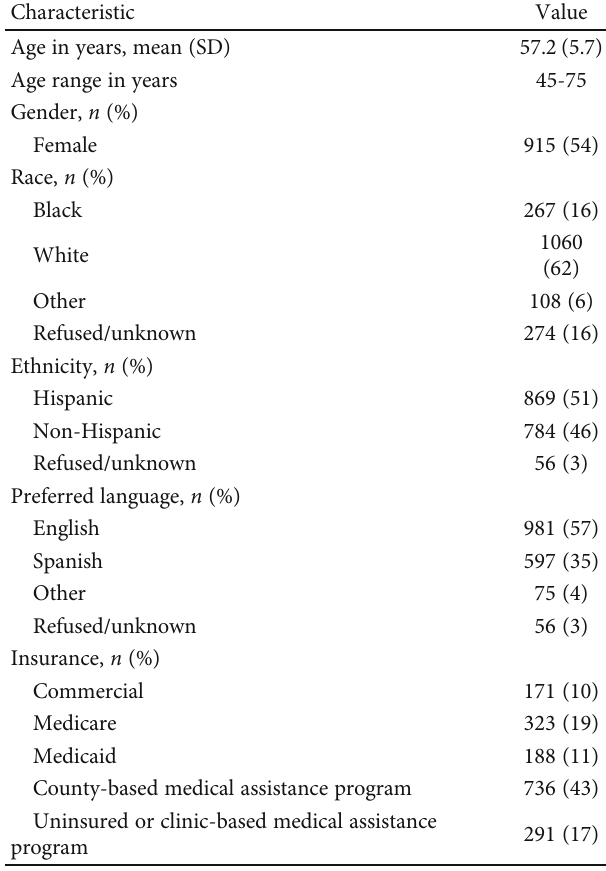
Table 1: Characteristics of patients from chart reviews ( n = 1709